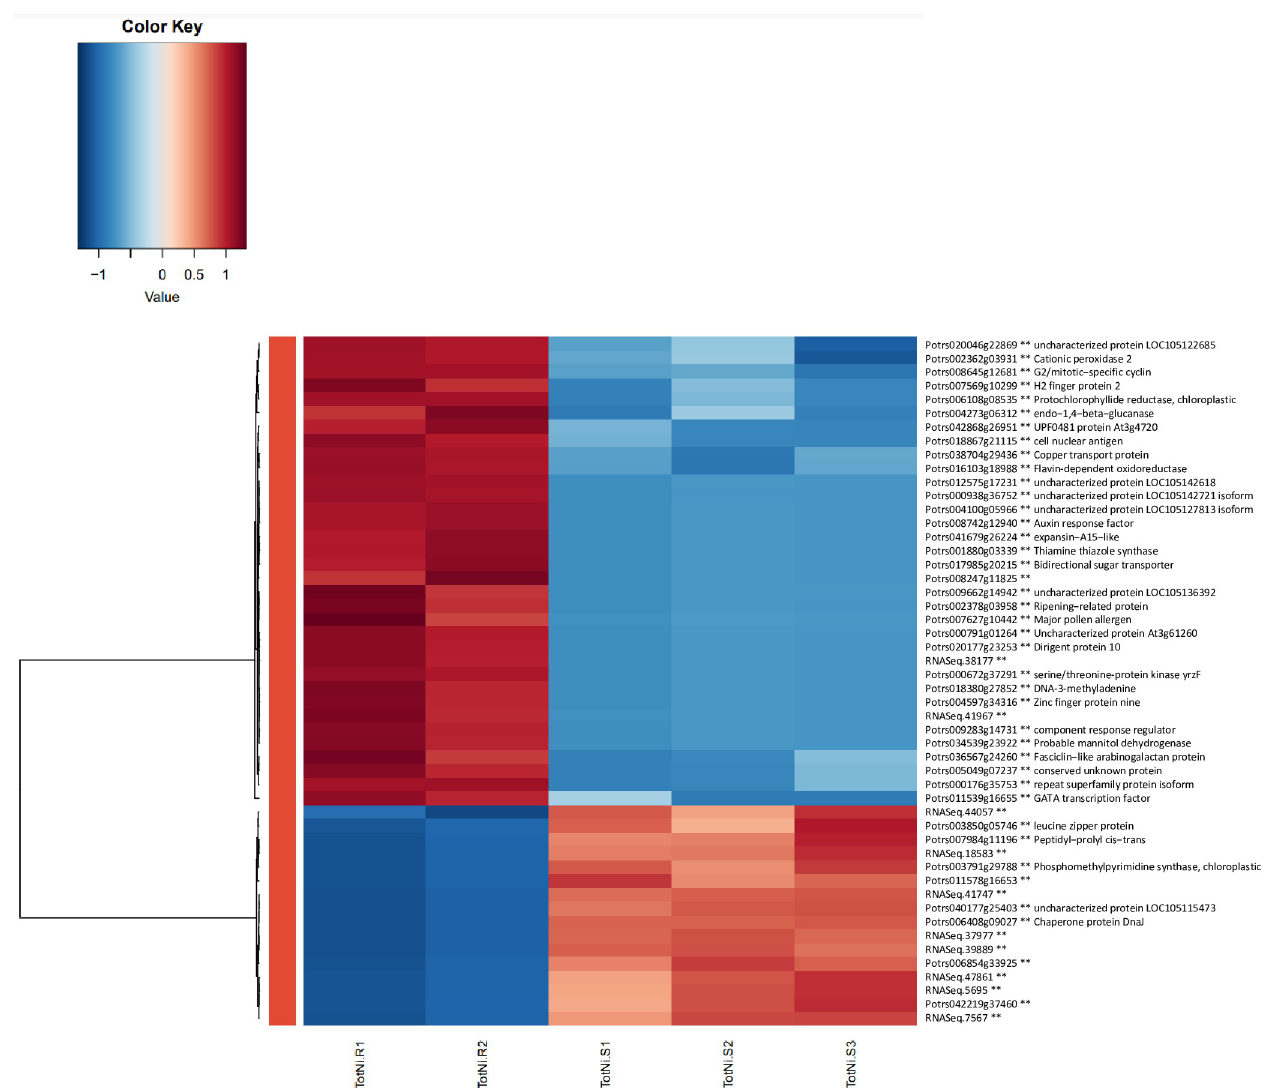
Fig 8. Top 50 differentially expressed genes between nickel resistant and susceptible Populus tremuloides based on LogFC. The red colour represents an upregulation and downregulation is blue.